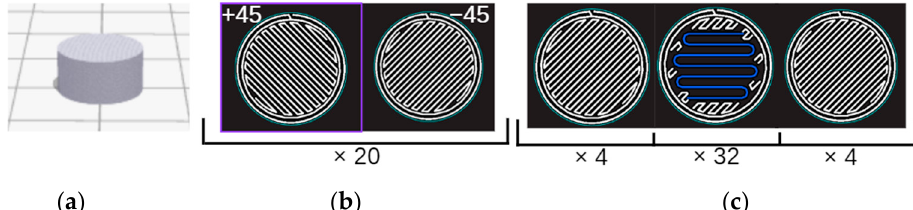
Figure 4. TMA sample details: ( a ) sample geometry; ( b ) ONYX sample architecture—40 layers of 0.125 mm thickness (alternating layers of ± 45 ONYX); ( c ) continuous carbon-fiber-reinforced ONYX sample architecture (blue—carbon filament reinforcement, white—ONYX matrix).